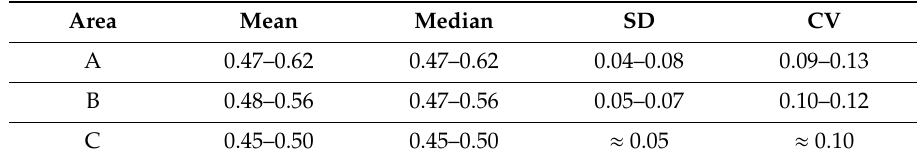
Table 3. Ranges of summarized statistics of normalized di ff erence red-edge (NDRE) vegetation index. SD is the standard deviation and CV is the coe ffi cient of variation.